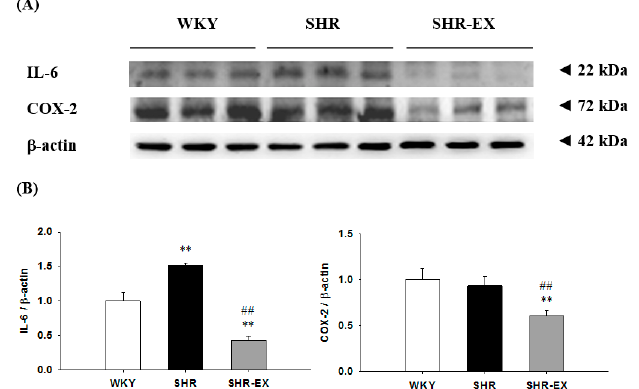
Figure 3. ( A ) The representative protein products of interleukin-6 (IL-6) and cyclooxygenase-2 (COX-2) extracted from the renal cortex of excised kidneys of Wistar-Kyoto rats (WKY), sedentary spontaneously hypertensive rats (SHR), and spontaneously hypertensive rats with exercise training (SHR-EX), as measured by Western blotting analysis; ( B ) the bars represent the relative protein quantification of IL-6 and COX-2 on the basis of β -actin and indicate mean values ± SD ( n = 8 in each group). ** p < 0.01 significant difference from the WKY group. ## p < 0.01 significant difference between the SHR group and SHR-EX group.